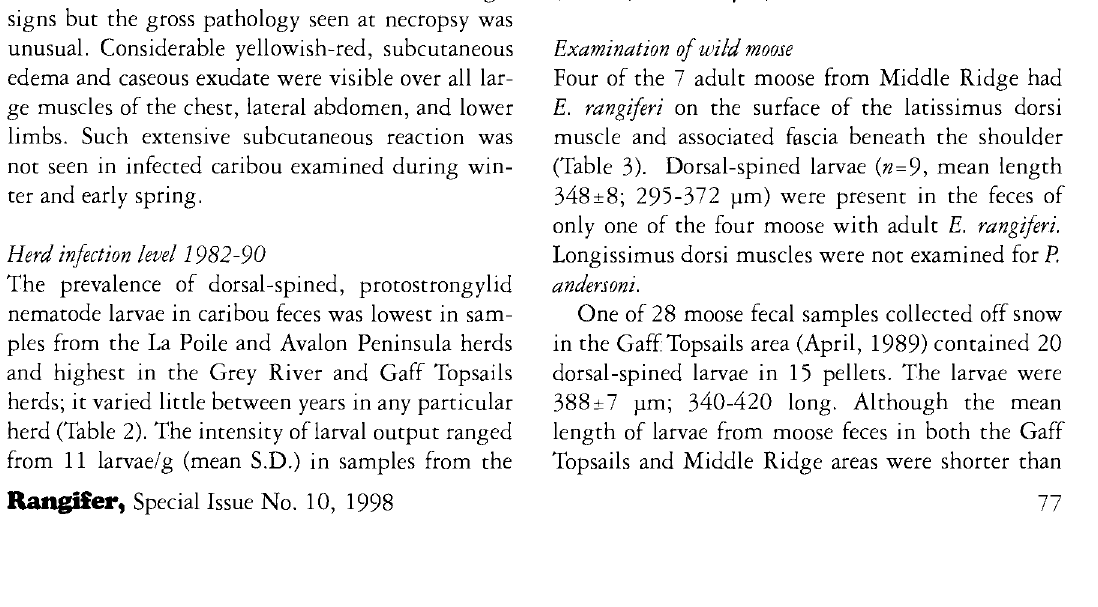
(Table 3). Dorsal-spined larvae (»=9, mean